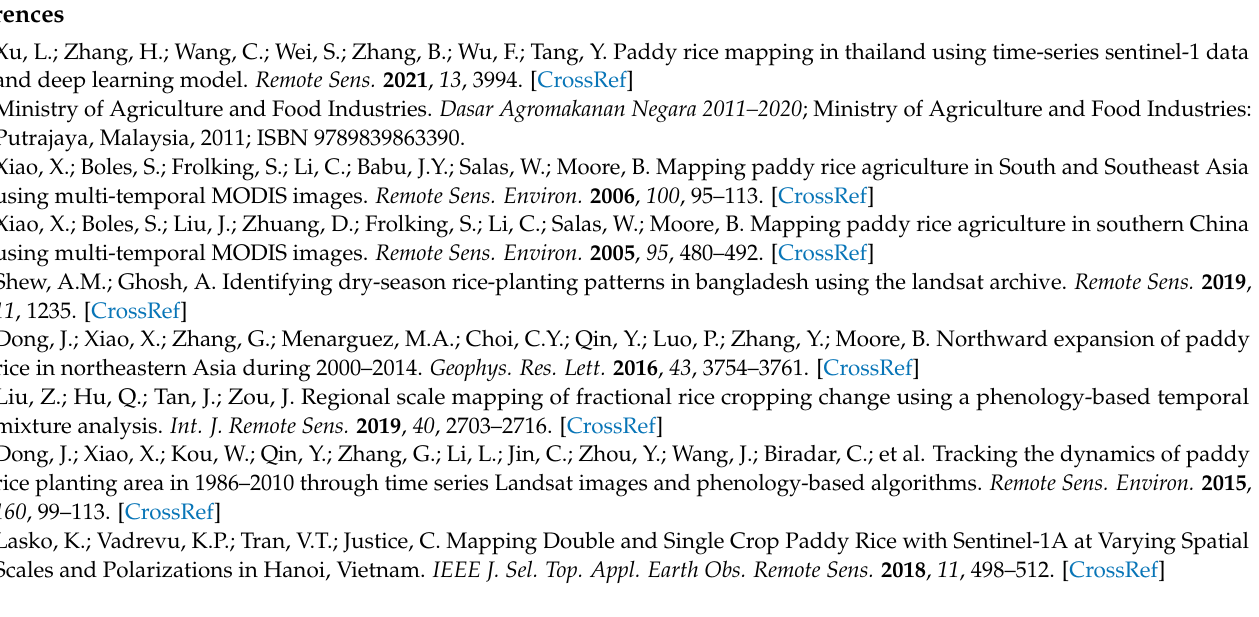
Table S1 corresponds to Figures 5–7 and Table 4. T = Tillage, V = Vegetative-1, V2 = Vegetative-2, R = reproductive, M = Maturity, F (blank) = Fallow. The code built for the mapping is available at Comparison between the rice extent map product from this study and NESEA-Rice10 is available